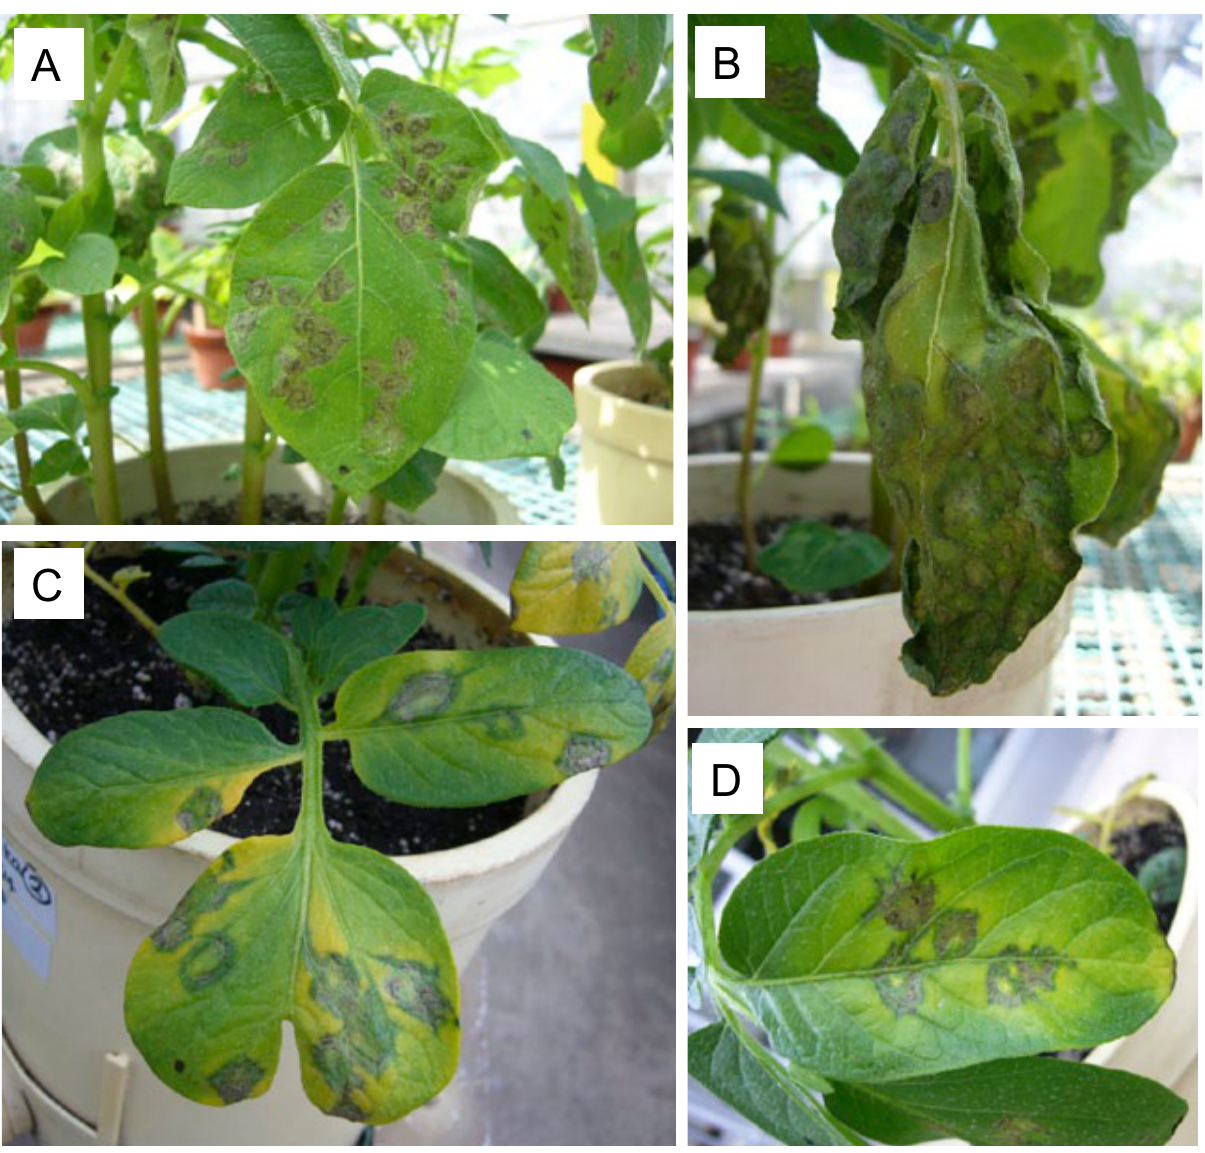
Figure 1. Local necrotic spots and rings induced by PoCMV7-5 in two potato cultivars: Maris Bard (A, B) and Nishiyutaka (C, D) which appeared about 1 week after